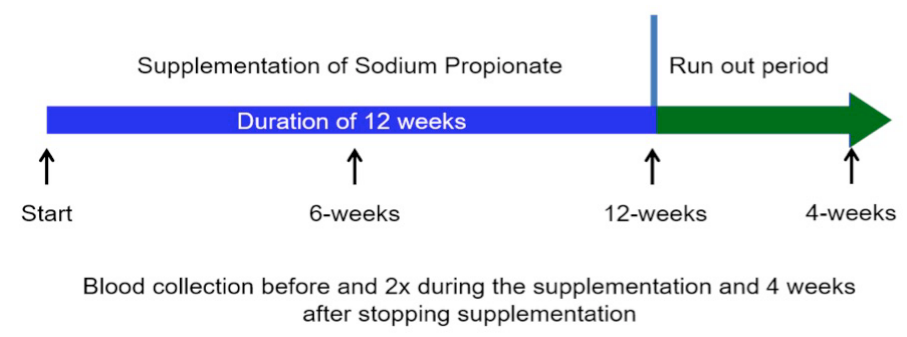
Figure 1. Representation of the study design. Blood samples were collected always before the start of the mid-week dialysis sessions. Table 2. Physical and biochemical parameters at the study baseline, after 6 and 12 weeks of intervention and 4 weeks after stopping the sodium propionate (SP) supplementation.